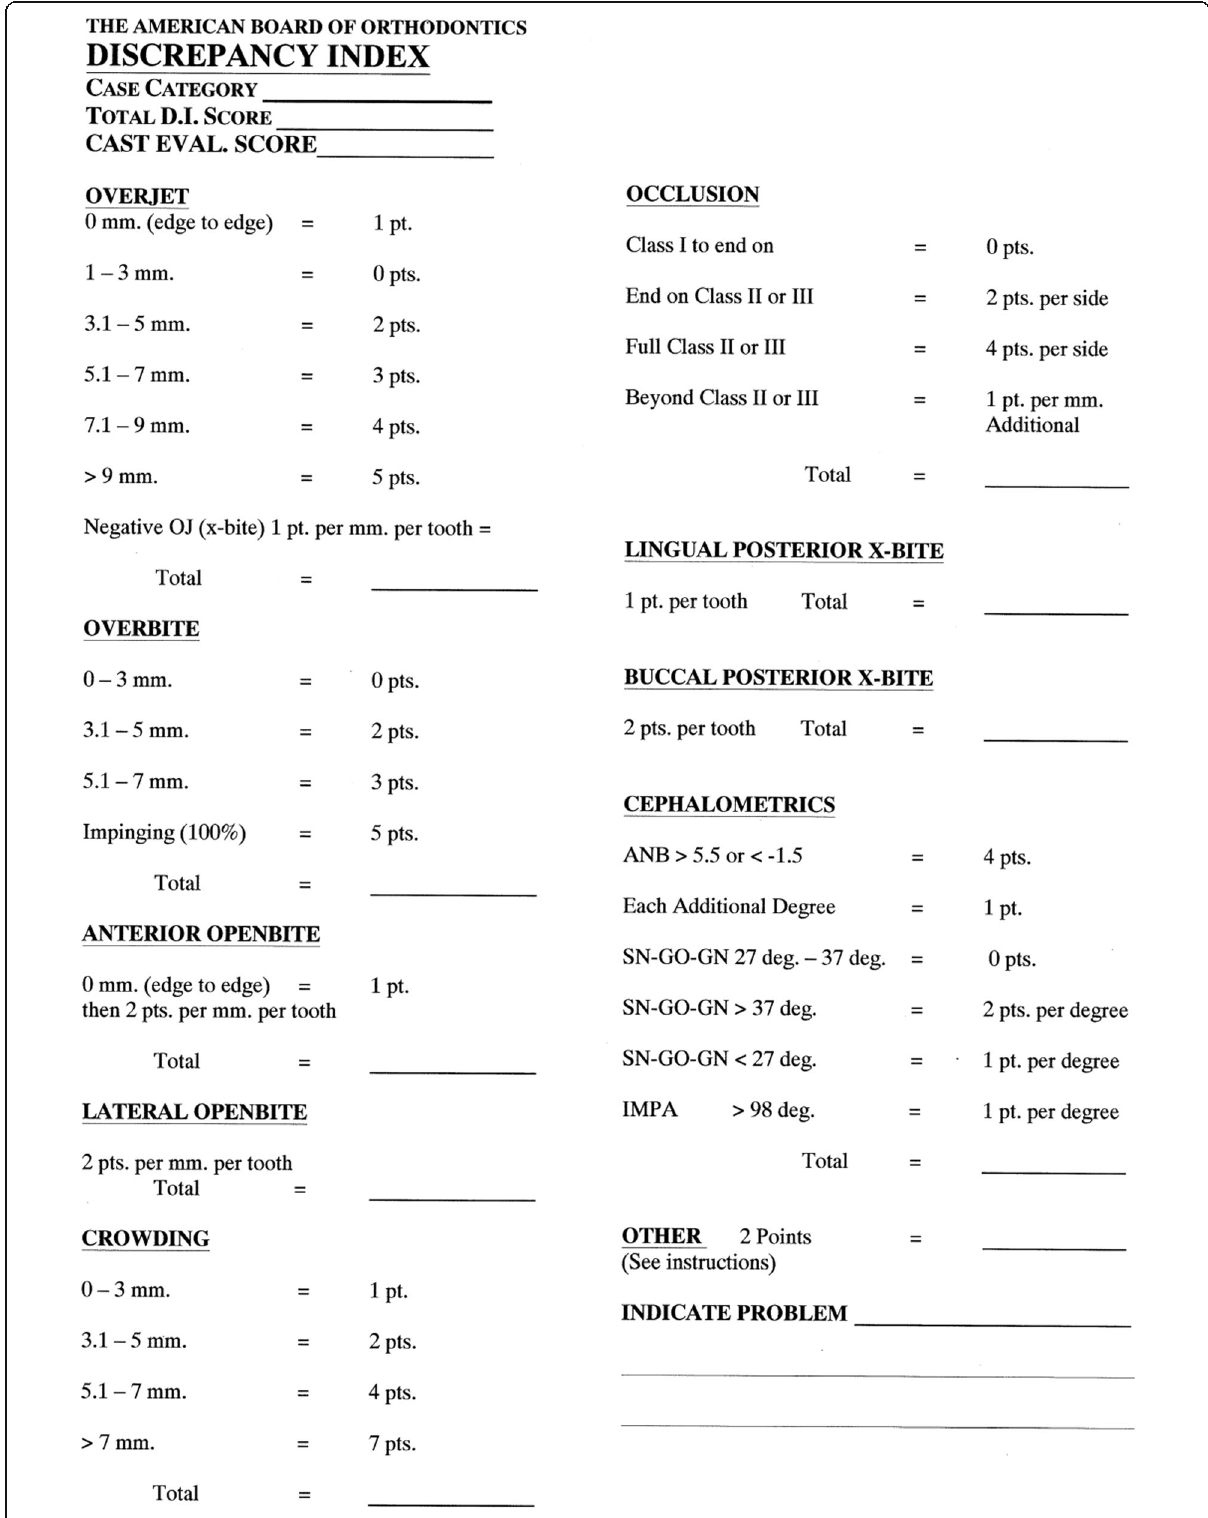
Fig. 1 The ABO discrepancy index